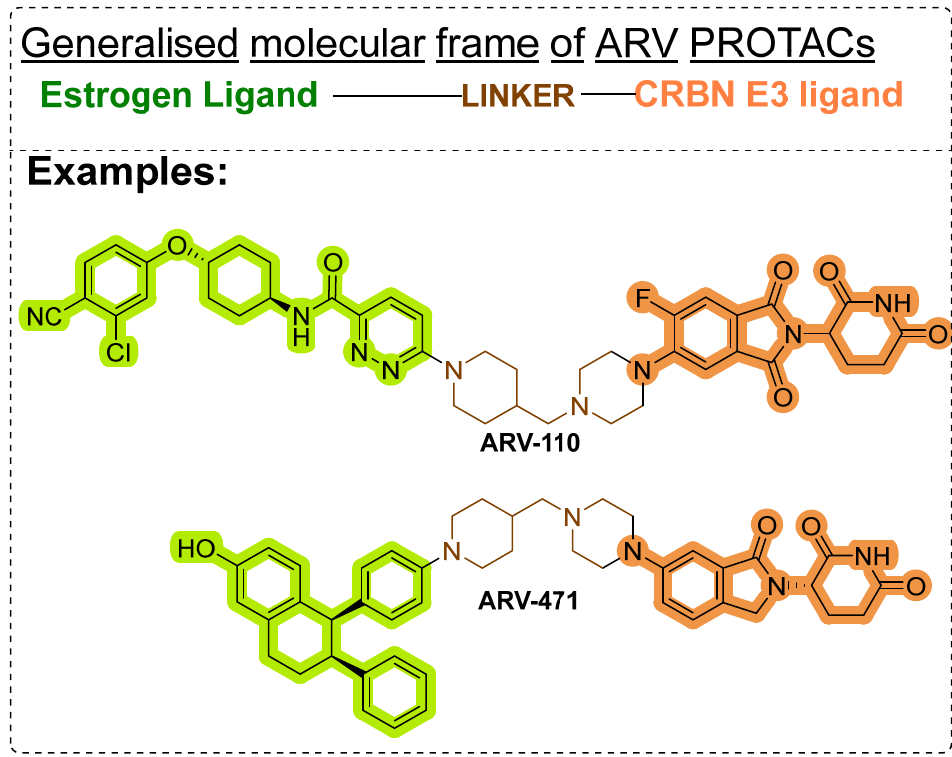
Figure 22. Molecular structure of ARV-110 and ARV-471 .